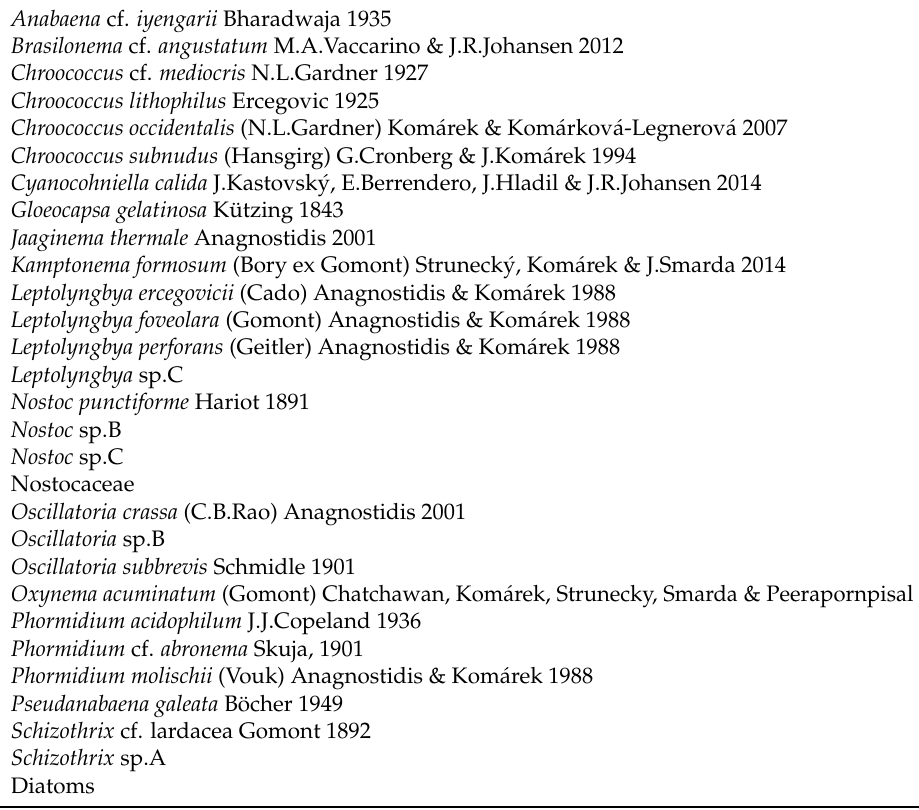
Figure 5. Back-scattered electron images (BSEI) presenting ( A ) laminated facies of stalactite, ( B ) lam- inae with shrubs that expand upward by irregular branching, ( C ) laminae consisting of micritic crystals of calcite and into it diatoms are trapped, ( D ) false color BSEI, derived from the correspond- ing black and white BSEI (see ( C )), displaying the distribution of Ca (purple), S (yellow) and Si (orange) where the diatoms are distinct, ( E , F ) holes and grooves in calcite crystals, suggesting the presence of endolithic Cyanobacteria.